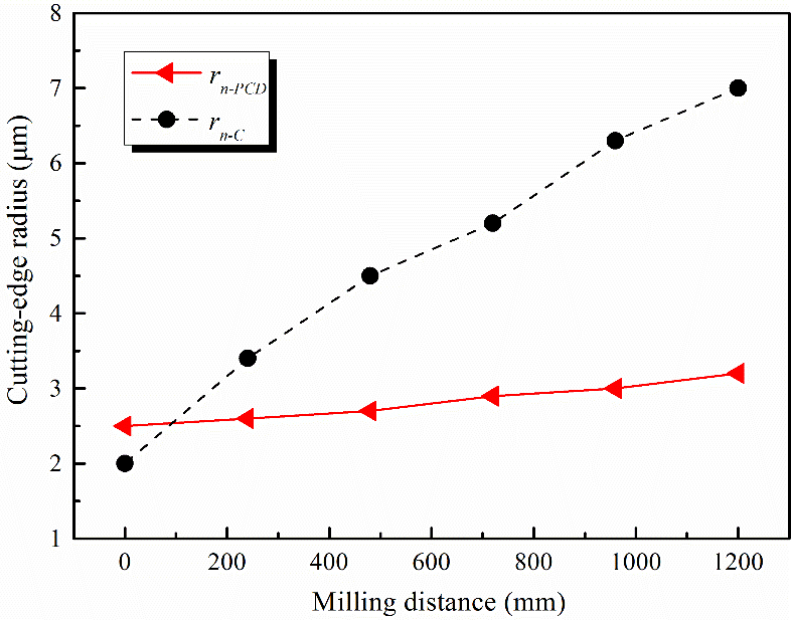
Figure 17. Variations of cutting-edge radii with milling distance.